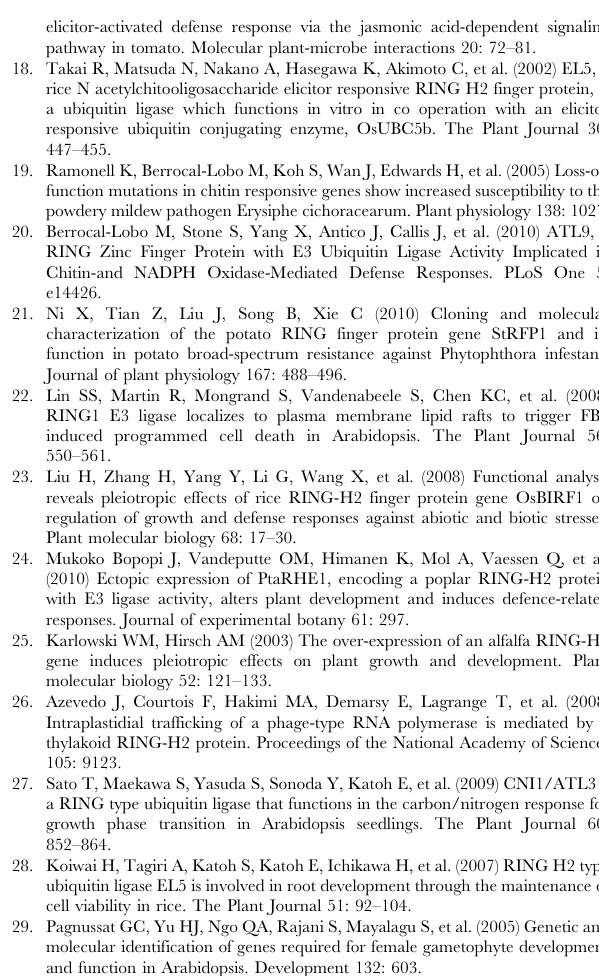
Table S3 Catalog of 75 sequence LOGOs generated from 1815 ATLs. Table S4 Tandemly arrayed ATL genes. Genes retrieved from 23 plant species. General information and motif architecture is displayed. Table S5 ATL10 interactors mapped to region